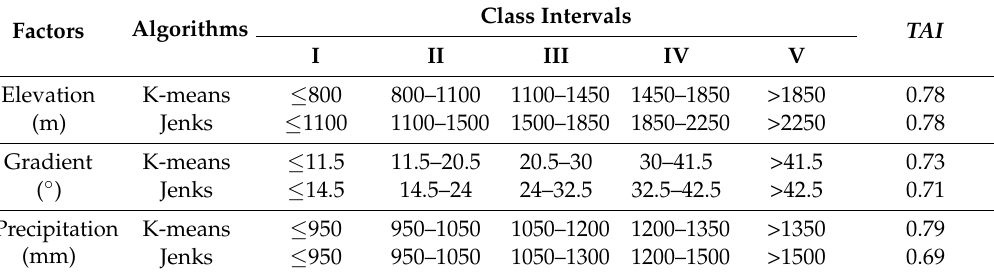
Table 3. Classification of elevation, gradient, and precipitation.